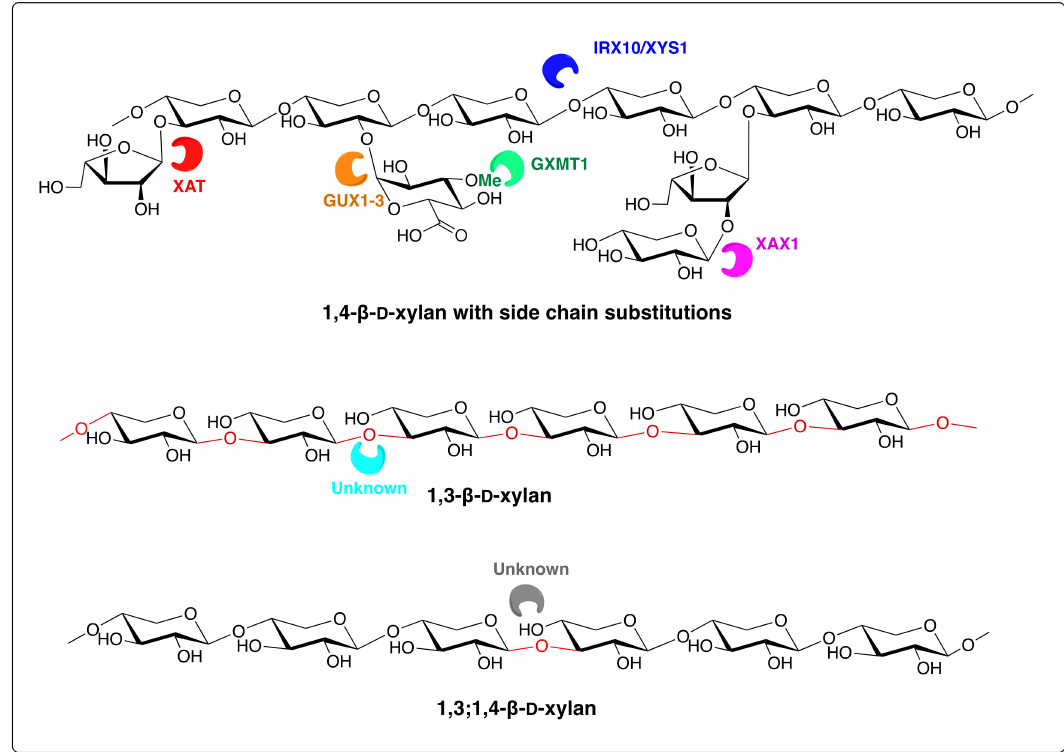
Figure 1. Structures of a 1,4- β - D -xylan with side-chain substitutions (a heteroxylan) as in the glucuronoarabinoxylans of the grass family (Poaceae) and the homoxylans 1,3- β - D -xylan and 1,3;1,4- β - D - D -xylan. The formation of the linkages shown are catalysed by the following enzymatic proteins: IRX10/XYS1 (irregular xylem 10/xylan synthase 1); XAT (xylan arabinosyl transferase); GUX1-3 (glucuronic acid substitution of xylan 1-3); GXMT1 (glucuronoxylan methyl transferase 1); and XAX1 (xylosyl arabinosyl substitution of xylan